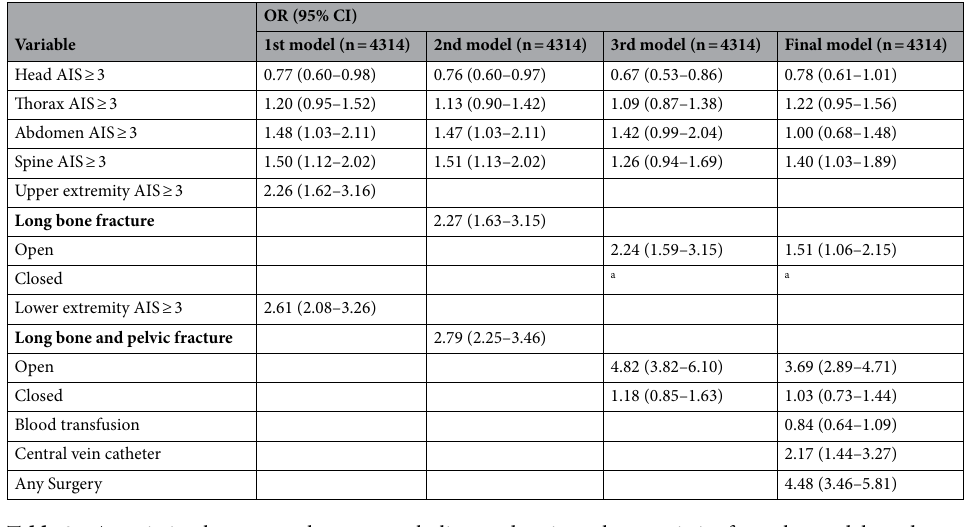
Table 3. Association between pulmonary embolism and various characteristics from the models under consideration. All the models were also controlled for comorbidities. The 3rd model and the final model were adjusted for unclassifiable fracture in lower extremity and pelvis. OR odds ratio, CI confidence interval, AIS Abbreviated Injury Scale score. a Covariate which was not used for the model because of less than 10 patients in PE group.